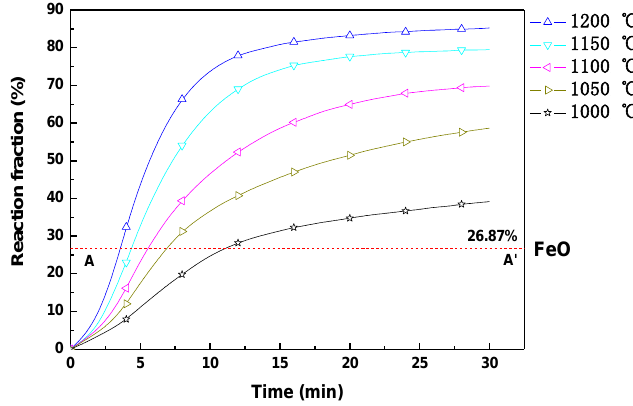
Figure 4. Results of the isothermal reduction experiment.